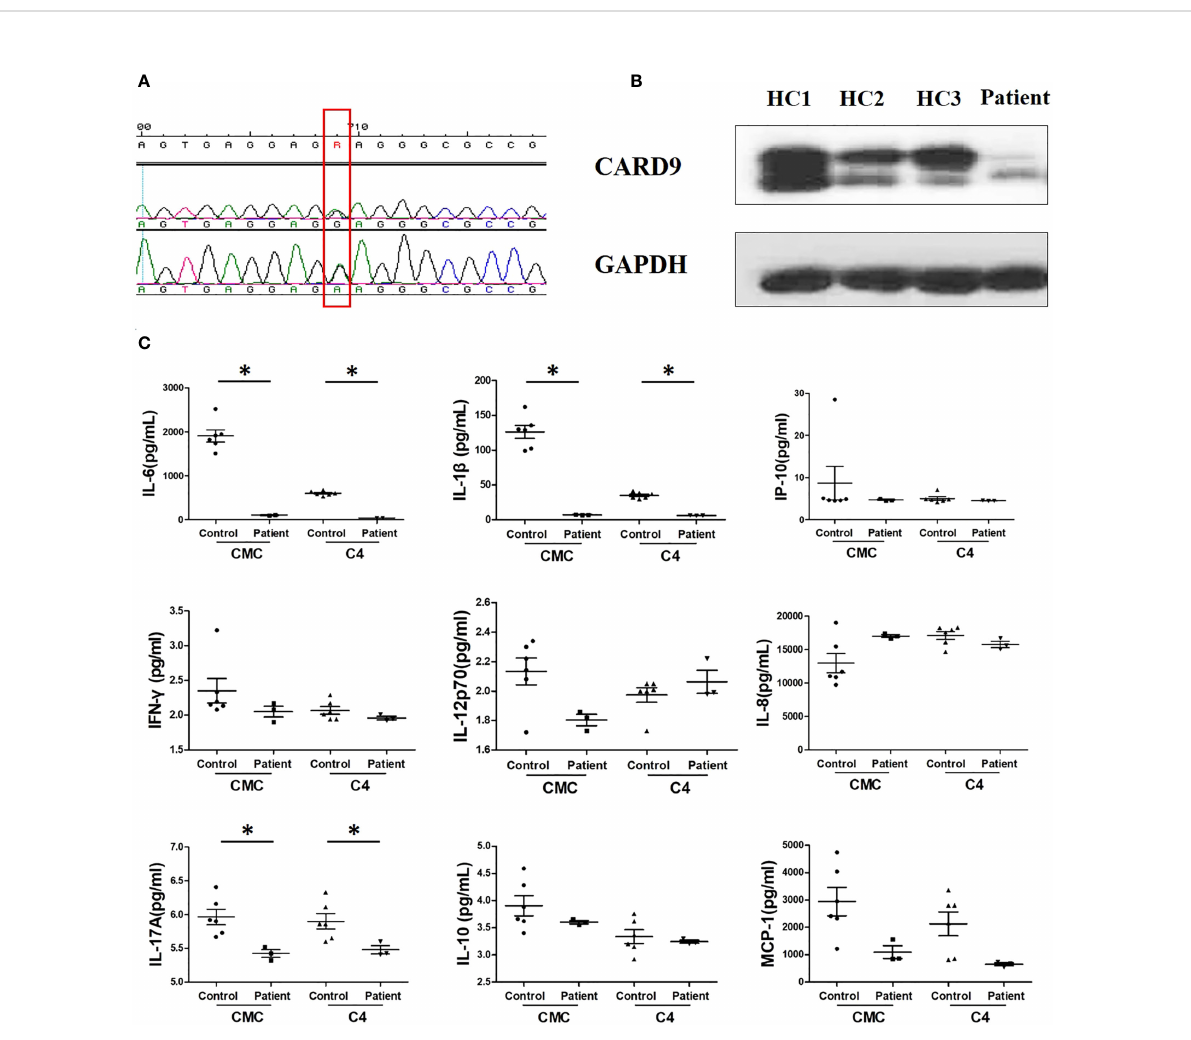
FIGURE 4 Results of immunological examination. (A) Sanger sequencing of CARD9 exon 4 reveals the heterozygous replacement of c.596A>R (red frame); F, forward chain; R, reverse chain. (B) Western blot of PBMCs showed decreased CARD9 levels, compared to healthy control; HC1, HC2, HC3, healthy control (C) Comparison of IL-1 b , IL-6, and IL-17A production between the patient and healthy control after stimulation with heat-killed isolates of patient strain (C4) and T. tonsurans wild-type strain (CMC), * P < 0.05, differences between groups were analyzed using Mann – Whitney U test. P- values reported in the study were based on a two-sided